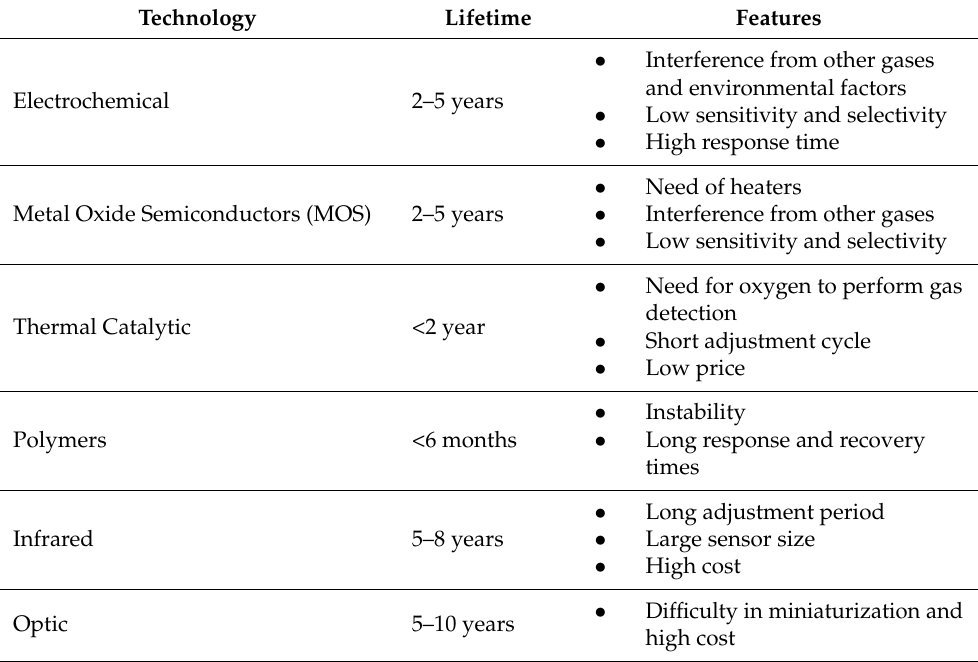
Table 1. Several gas sensing technologies available for IoT-enabled gas